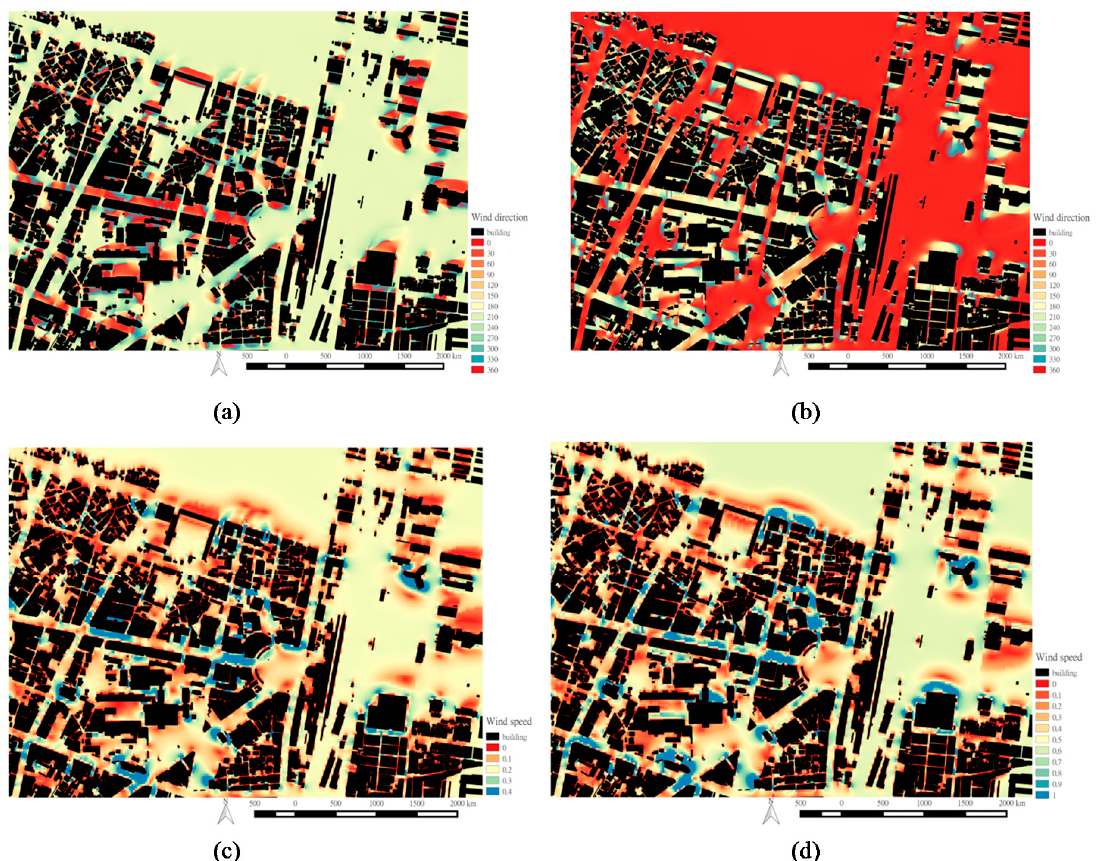
Figure 6. ( a ) WD in 31 July 2015; ( b ) WD in 21 January 2016; ( c ) WS in 31 July 2015; and ( d ) WS in 21 January